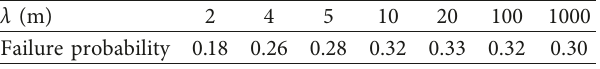
Figure 9: Illustration of vertical spatial variability of S slope. Table 2: Variation of failure probability with different λ values for the cohesive slope.